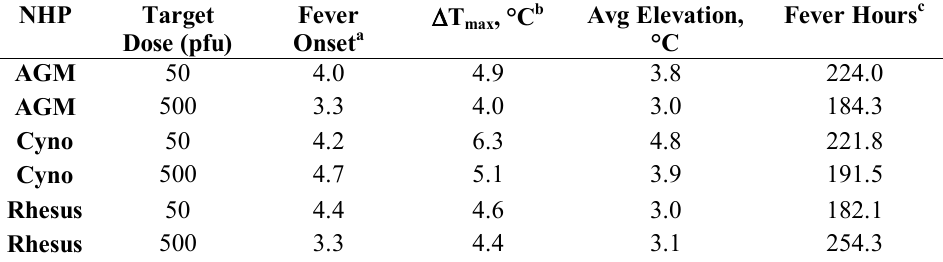
Table 2. Summary of fever